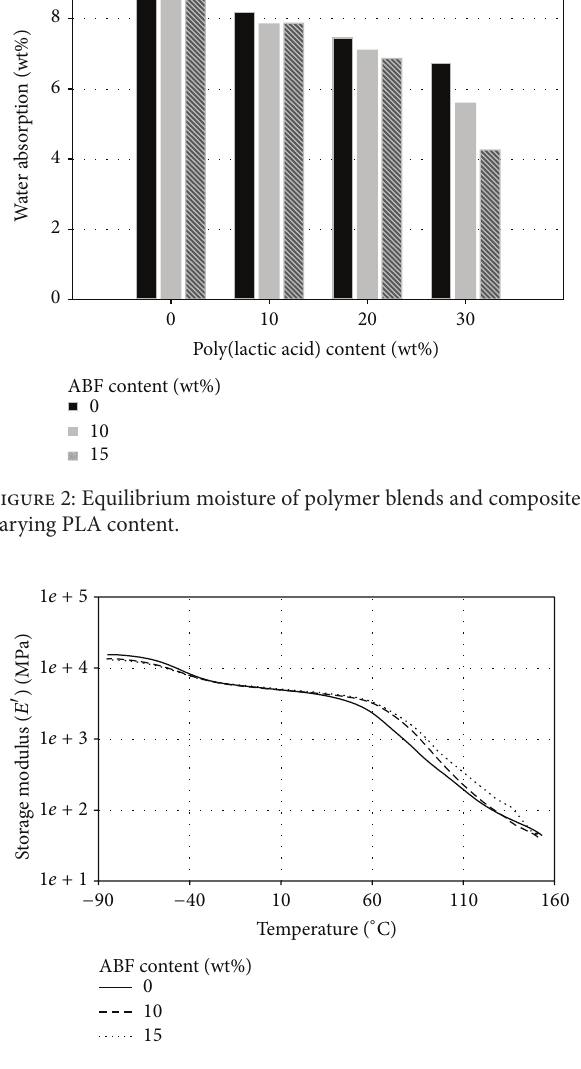
Figure 3: Storage modulus as a function of temperature for the polymer blend and composites containing 20 wt% of